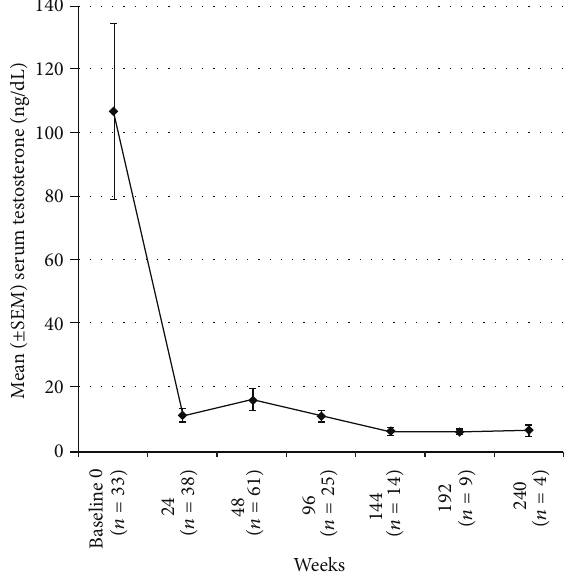
Figure 1: Mean serum testosterone levels (ng/dL) in patients after receiving once-yearly histrelin acetate implants for 240 weeks. The error bars represent the standard error of the mean (SEM).